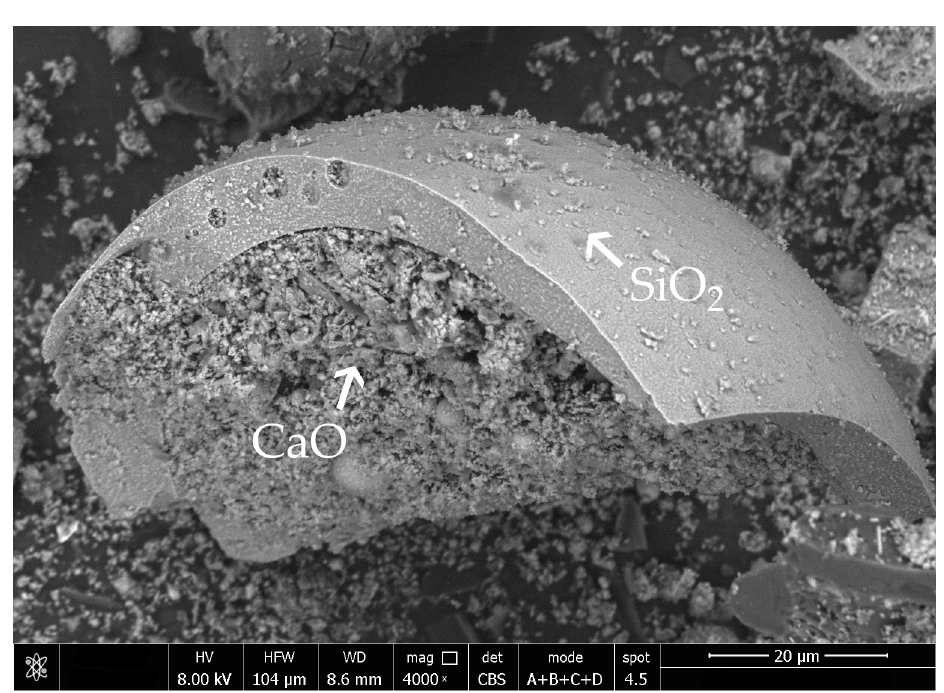
Figure 4. SEM photography of ground biomass fly ash with visible calcium oxide particles inside a broken silicate sphere. Table 8. Chemical Oxide Composition of Sieved and Ground Biomass Fly Ash Compared with untreated Fly Ash.